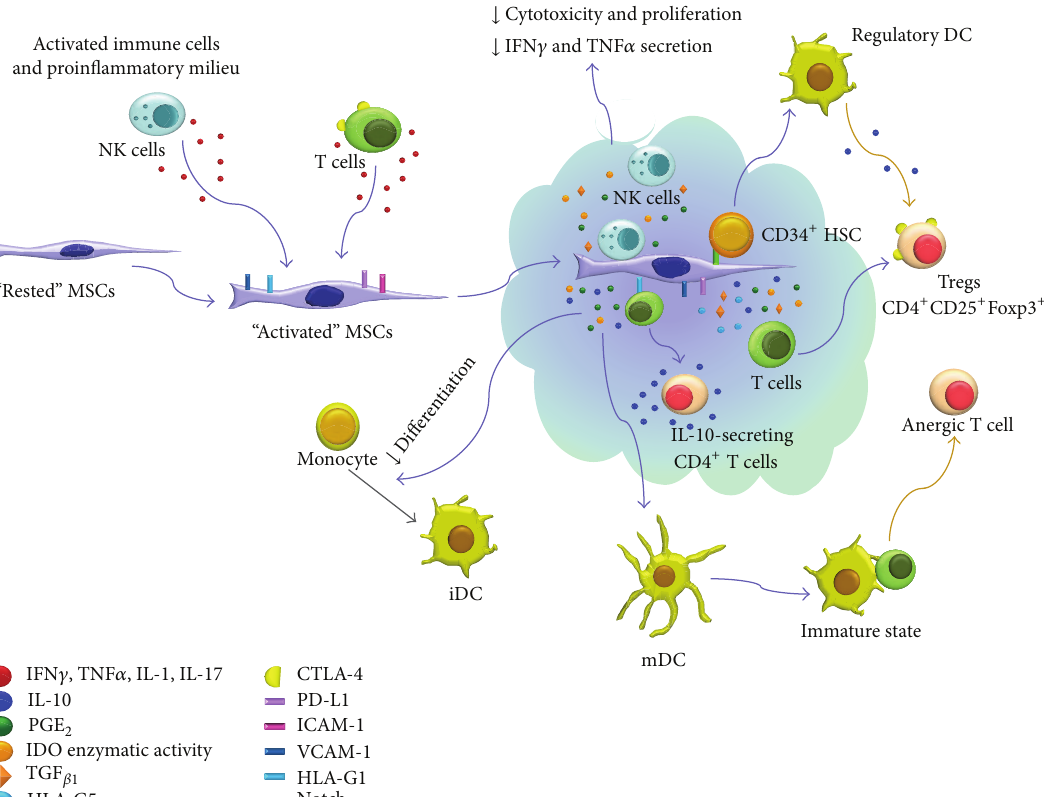
Figure 2: Immunoregulatory effects of MSCs on immune cells. Proinflammatory cytokines such as IFN 𝛾 secreted by activated NK cells and T lymphocytes support MSCs-mediated immunoregulation and can increase or induce the production of immunosuppressive molecules. IDO, PGE 2 , TGF 𝛽1 , and membrane molecules are mainly involved in MSCs immunoregulation on NK cells. IDO, PGE 2 , and IL-10 are involved in the decrease of differentiation of monocytes into iDCs and may push mDCs toward an immature state, which results in T-cell anergy and inappropriate activation of T lymphocytes. MSCs induce the differentiation of CD34 + hematopoietic progenitors into a population of regulatory DCs, which in turn stimulate the generation of Foxp3 +